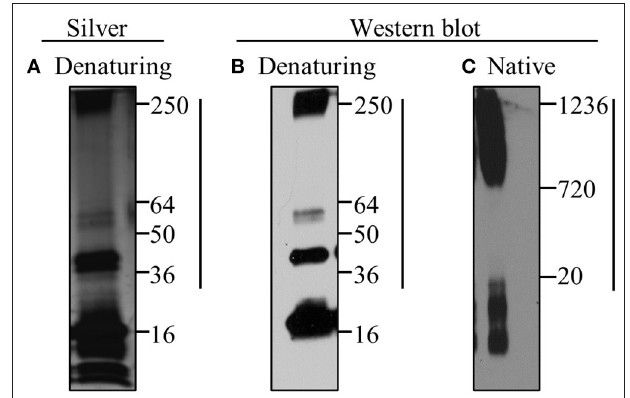
FIGURE 1 | Misfolded A53T contains α -synuclein oligomers. Misfolding of recombinant A53T was induced by subjecting the protein to 37 ◦ C and rotation. Misfolded A53T was subjected to (A) silver stain and (B,C) western blot analyses with the human specific α -synuclein antibody (Syn211; Thermo Scientific; 1:1000) following (A,B) denaturing and (C) native gel electrophoresis. A53T monomer is ∼ 16kDa and larger oligomeric conformers